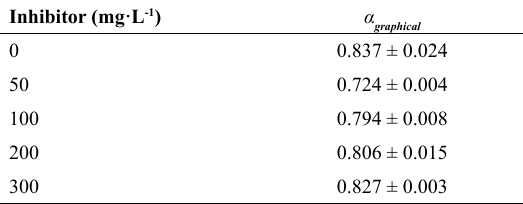
Figure 6. Imaginary part of the impedance as a function of frequency at 25.0 °C. Table 2. Values of α graphically